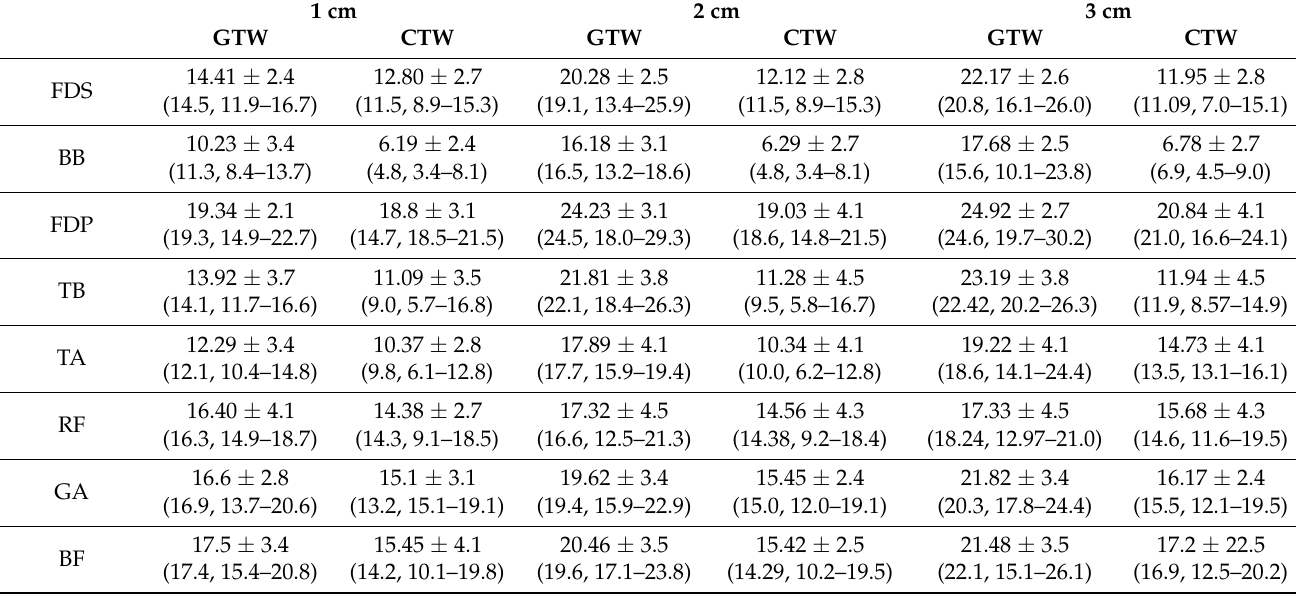
Table 5. Upper and lower extremity muscle activity in obstacle terrain (M ± SD (median,